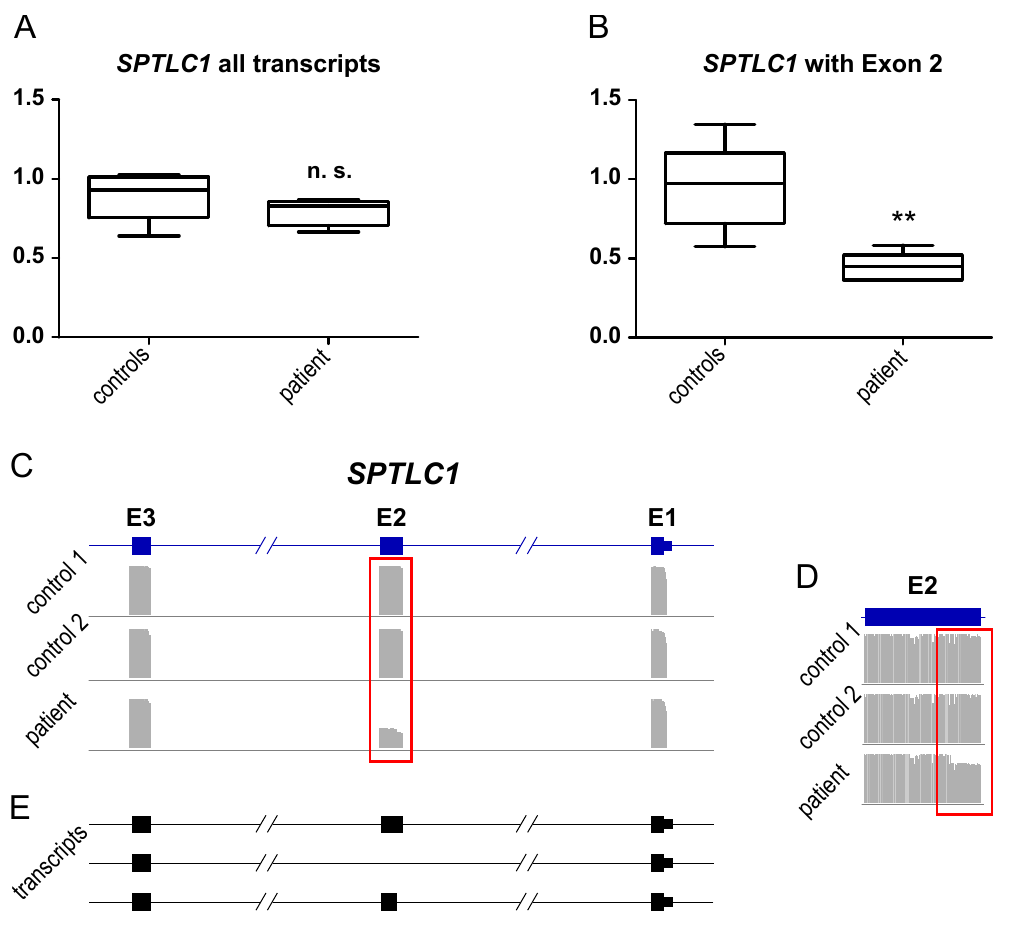
Figure 6. SPTLC1 expression in lymphocytes: RNA was extracted from immortalized lymphocytes derived from the patient and healthy controls. cDNA was generated with random hexamer primers to perform expression analysis of SPTLC1. mRNA expression was calculated via ∆∆ Ct method using B2M for normalization. The SPTLC1 expression was normalized to the healthy controls. Boxes indi- cate the lower and upper interquartiles, horizontal lines indicate the median, and whiskers indicate the minimum-to-maximum values. ** p < 0.01, n. s. not significant, by Mann–Whitney test. ( A ) SPTLC1 expression of all transcripts. ( B ) SPTLC1 expression of transcripts containing exon 2. cDNA from healthy controls and the patient were amplified and used for ligation-based nanopore library preparation and sequencing. IGV coverage plots of SPTLC1 exons 1–3 ( C ) or exon 2 ( D ), respec- tively. ( E ) Compositions of the different SPTLC1 transcript detected by nanopore sequencing in the patient.